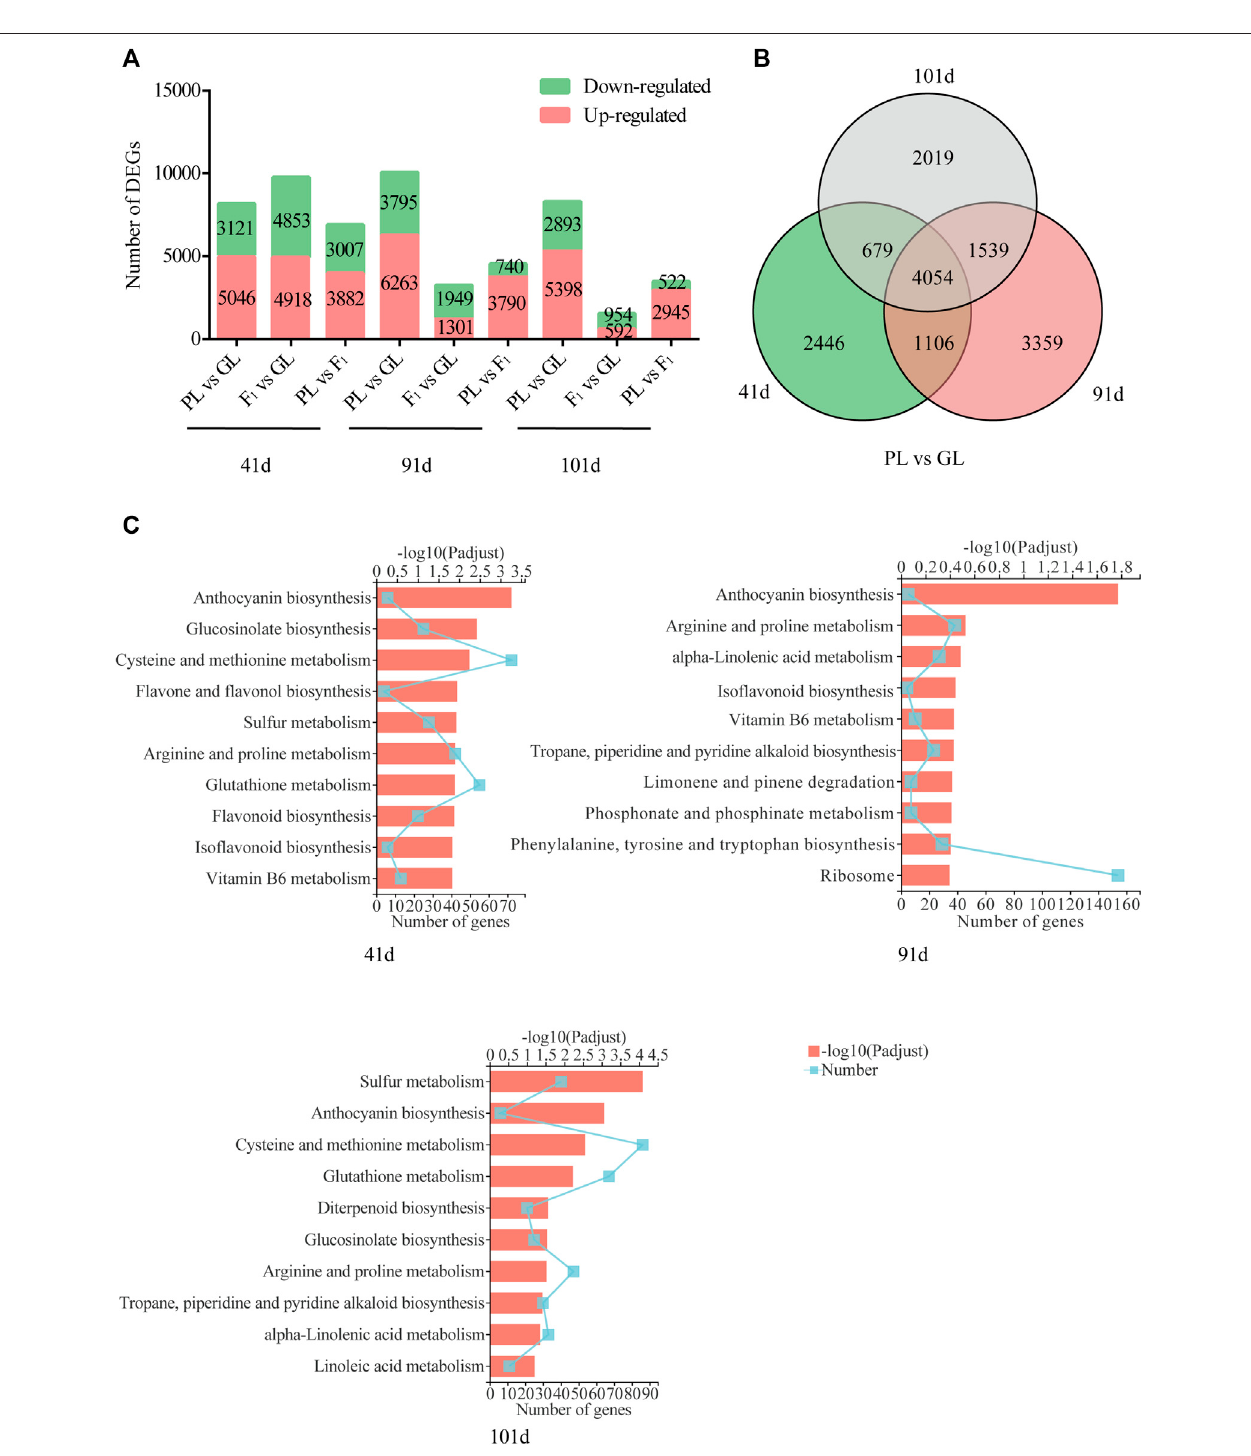
FIGURE 3 | Summary of differentially expressed genes between GL and PL. (A) The number of DEGs among GL, F 1 , and PL. (B) Venn diagrams of differentially expressed genes between PL and GL shared at different developmental stages. (C) The KEGG enrichment of DEGs between PL and GL at different developmental